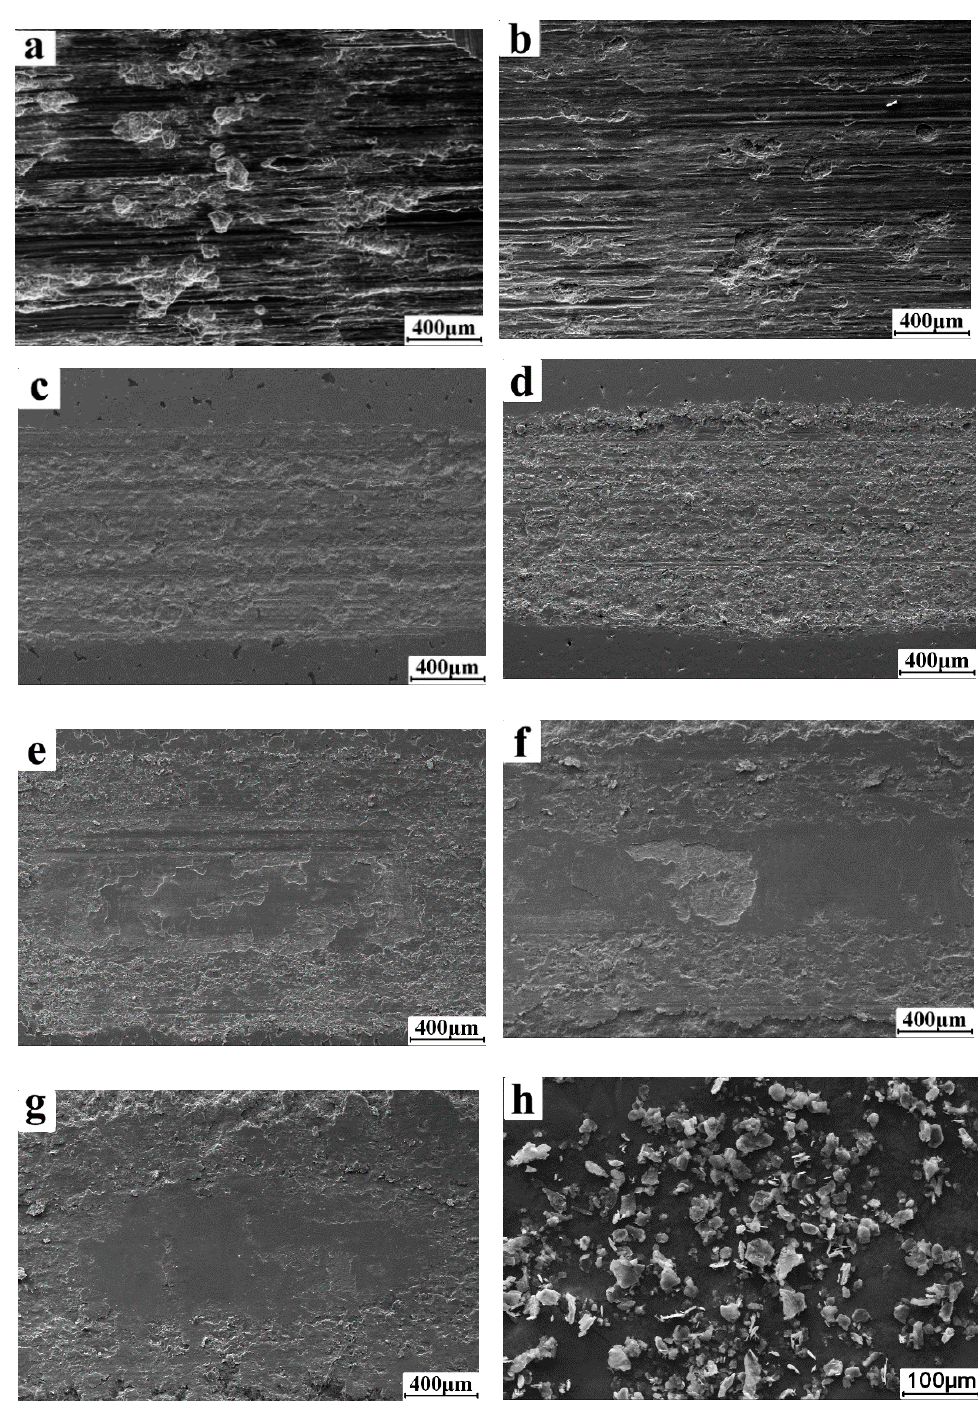
Figure 6. Wear scar morphology of each coating type and graphite powder: ( a ) Mg, ( b ) micro-arc oxidation, ( c ) 20 wt%, ( d ) 40 wt%, ( e ) 60 wt%, ( f ) 80 wt%, ( g ) 100 wt%, and ( h ) graphite powder.